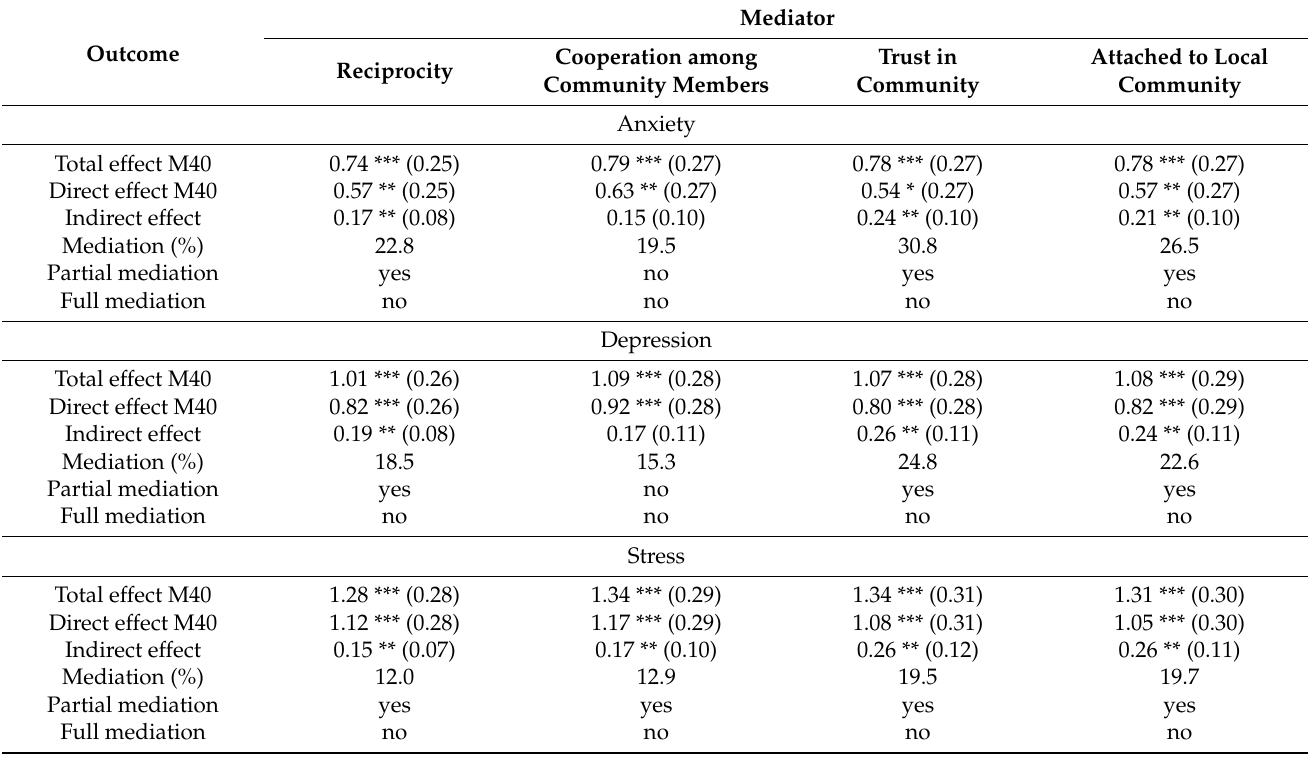
Table 2. Mediating effects of social capital on the association between income groups and anxiety, depression, and